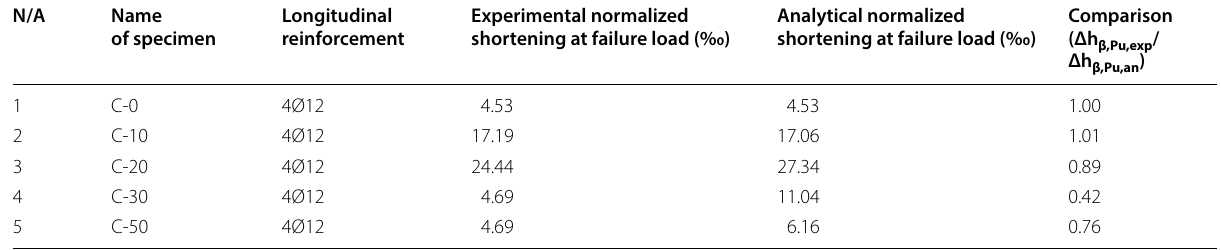
Table 10 Comparison between measured and empirical normalized shortening at maximum failure load. N/A Name of